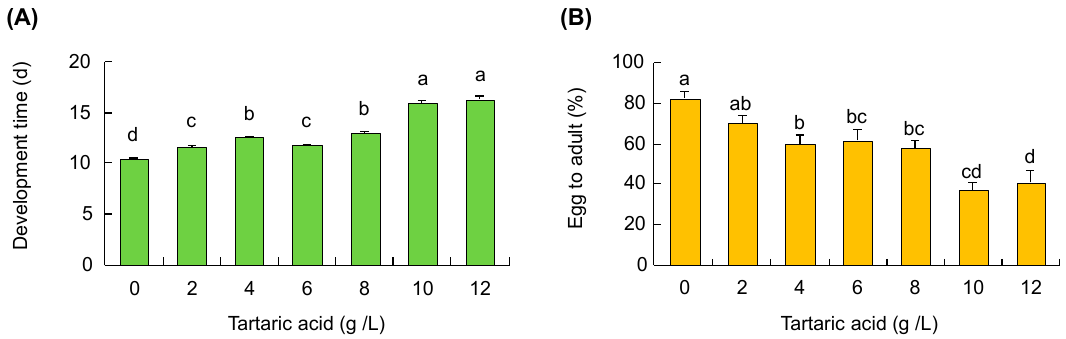
Figure 4. E ff ects of tartaric acid on ( A ) developmental time and ( B ) the o ff spring survival (eggs Figure 4. Effects of tartaric acid on ( A ) developmental time and ( B ) the offspring survival (eggs developed to adults) of D. suzukii . Bars refer to mean ± SE, and di ff erent letters over the bars indicate developed to adults) of D. suzukii . Bars refer to mean ± SE, and different letters over the bars indicate significant di ff erence (One-way ANOVA and Tukey’s HSD, p < significant difference (One-way ANOVA and Tukey’s HSD, p < 0.05).